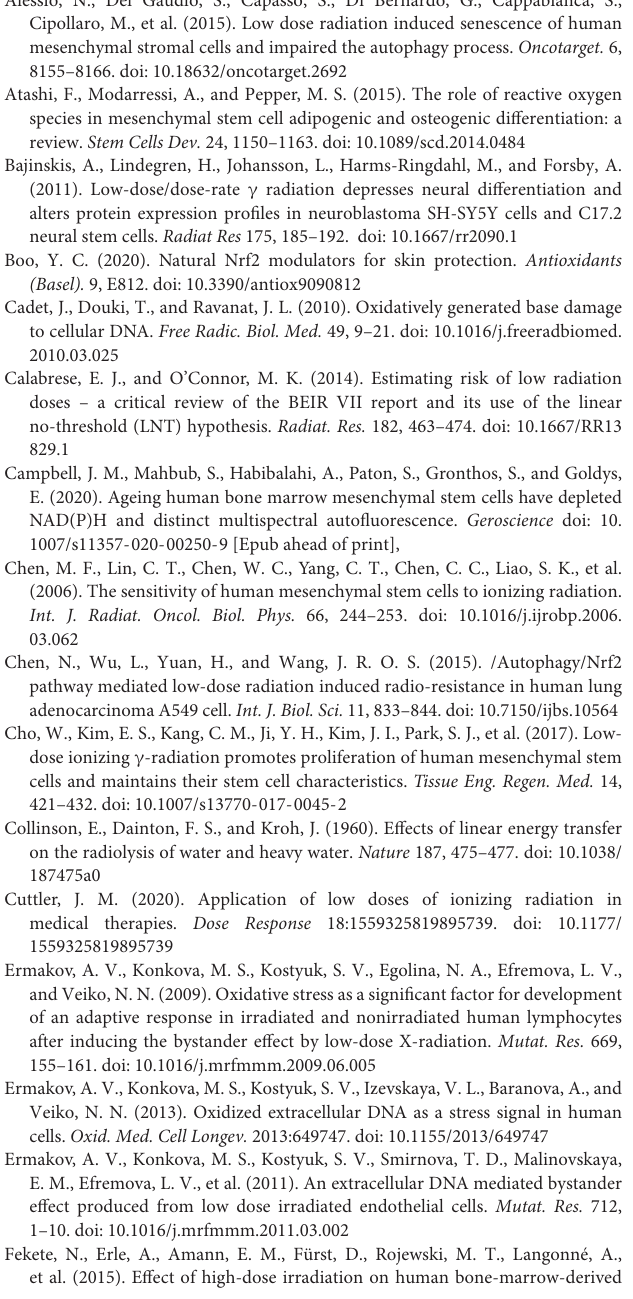
filters. (B) FACS. UVa irradiation effect on the MSCs and HSFs auto- fluorescence. Supplementary Figure 2 | (A) FACS. (1) Plots: FL1-NRF2 versus SSC. R: gated area, cells with an increased NRF2 expression. (2) The distribution of the MSCs (10 cGy) with varying NRF2 signal. (3) The content of the cells with an increased NRF2 expression. (4) Median signals for FL1 – NRF2. Average values and SD are given for three experiments. ∗ p < 0.001 ( U test). (B) Fluorescence microscopy. The dependence of FL1- NRF2 on FL1 – NOX4 changes in #2303 MSC (10